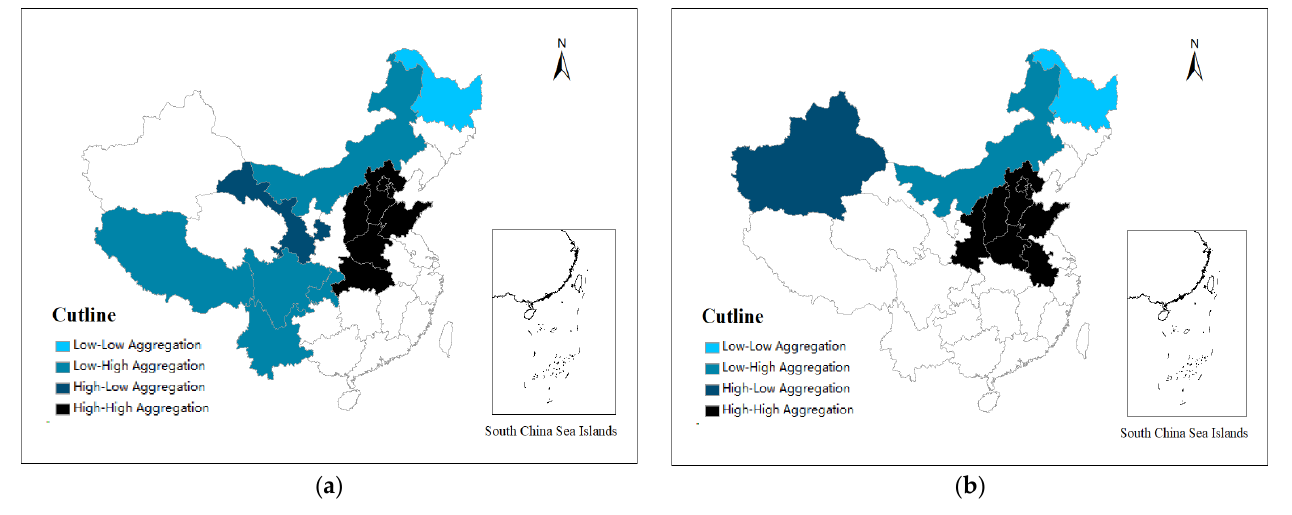
Figure 3. PM2.5 LISA cluster map. ( a ) 2003. ( b ) 2008.